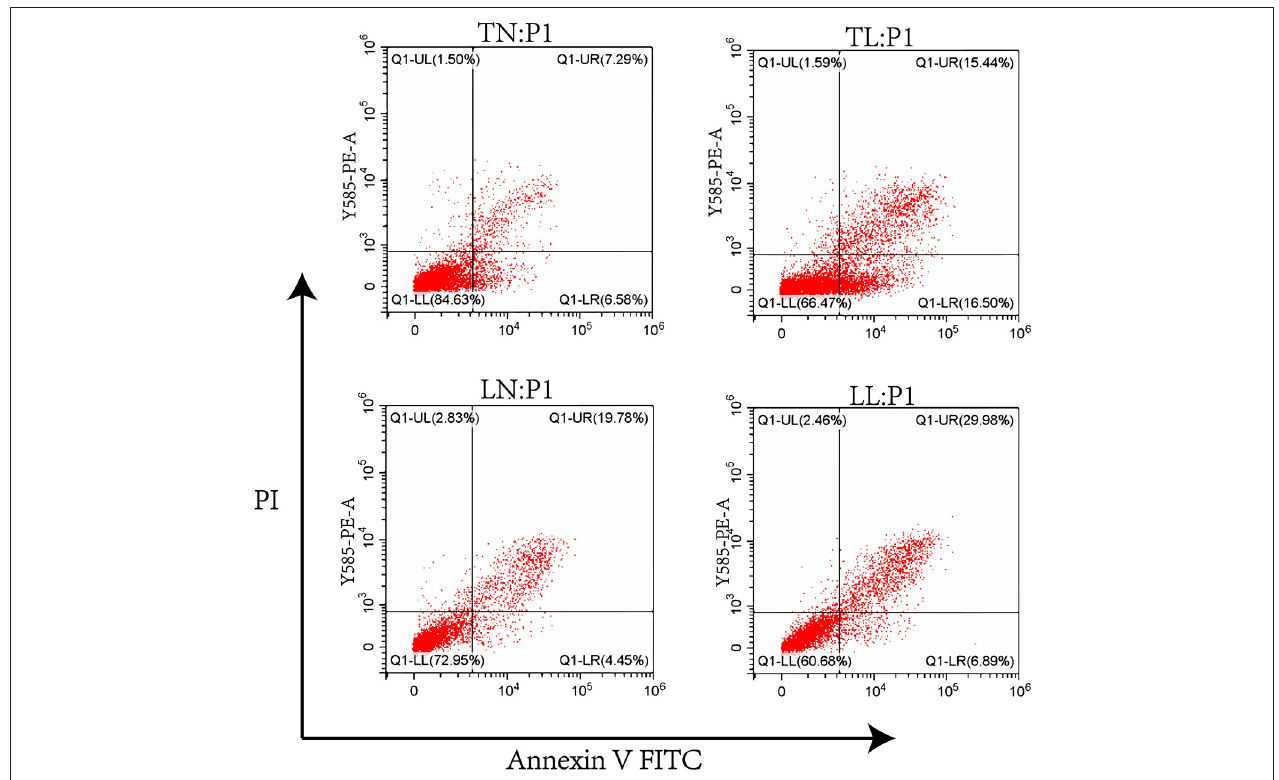
FIGURE 6 | The apoptosis of ATII cells from Tibetan pigs and Landrace pigs under normoxic (21% O 2 ) and hypoxic (2% O 2 ) condition was determined.